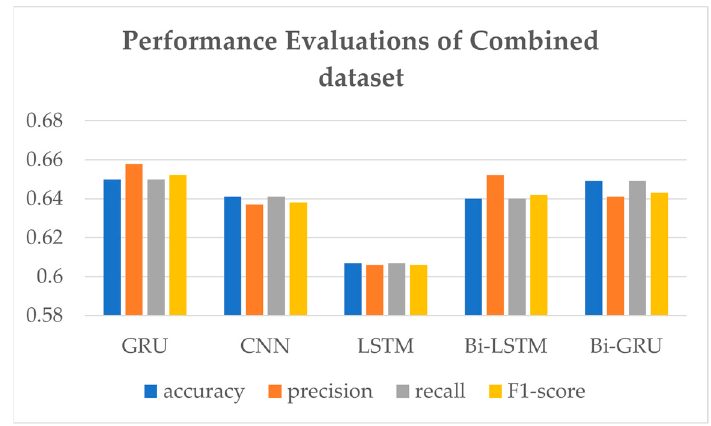
Figure 8. Bar table of performance evaluations of the combined dataset.